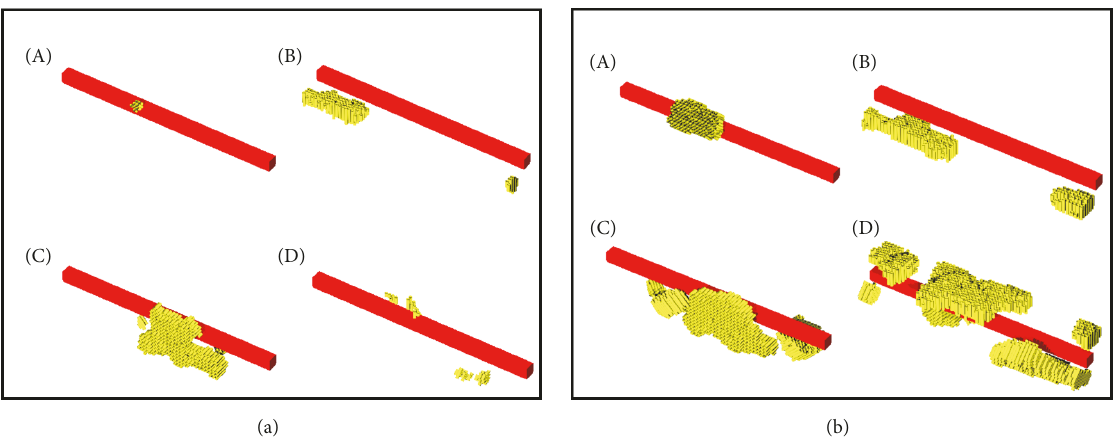
Figure 8: Snapshots of small crystallites appearing at the beginning of crystallization (a) and crystalline morphologies at 300000 MC cycles (b) for grafted polymer systems with 64(A), 84(B), 128(C), and 252(D) polymer chains. Yellow cylinders denote the crystalline stems, and red parts denote the